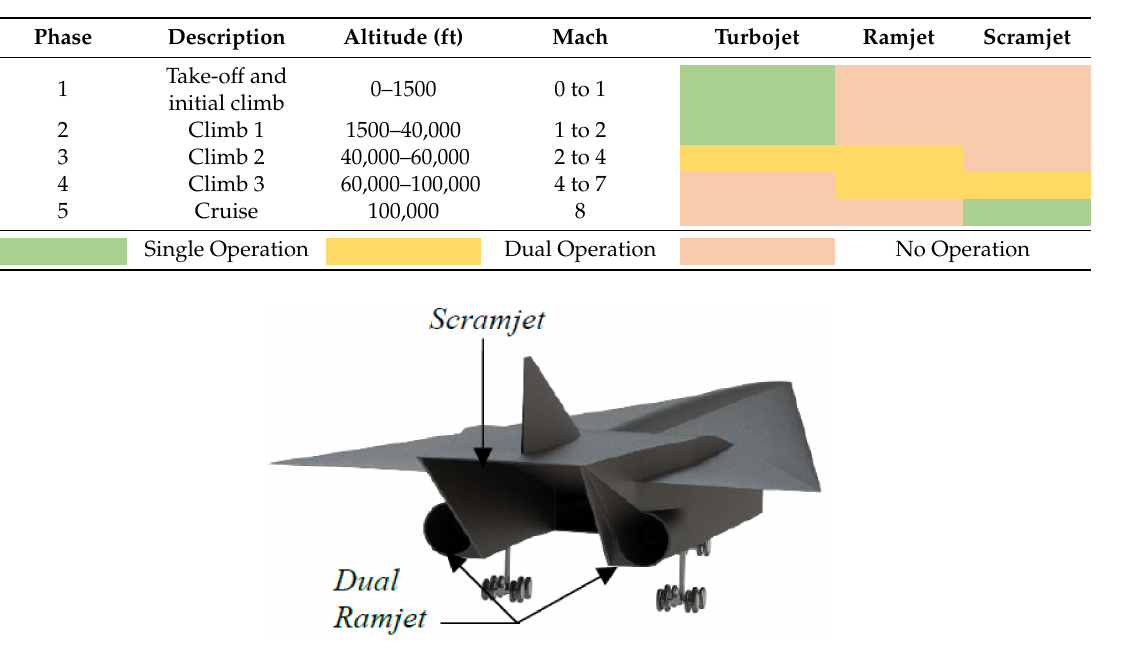
Figure 1. Concept hypersonic